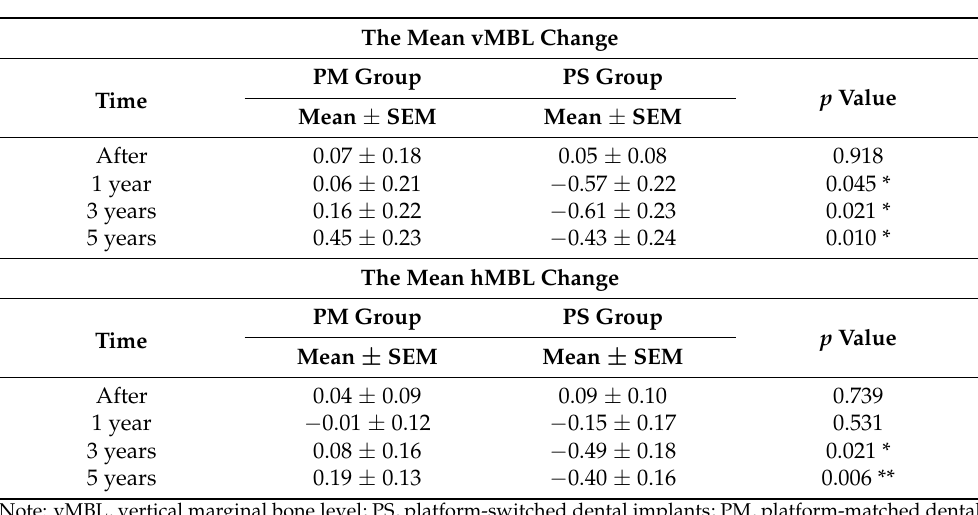
Table 4. Comparison of the mean vMBL and hMBL change between the two